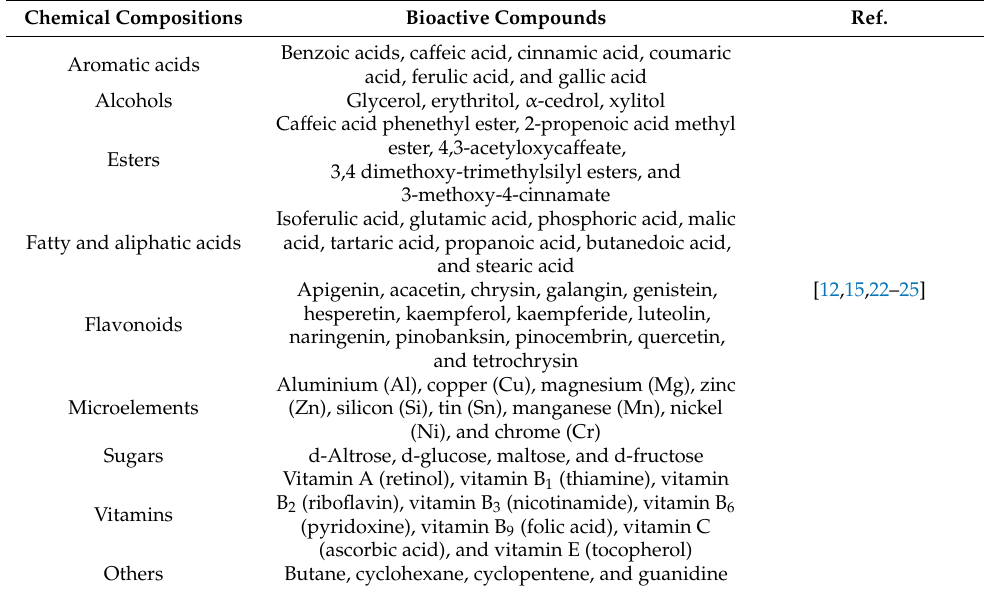
Table 1. Chemical compositions of propolis and their bioactive compounds. Chemical